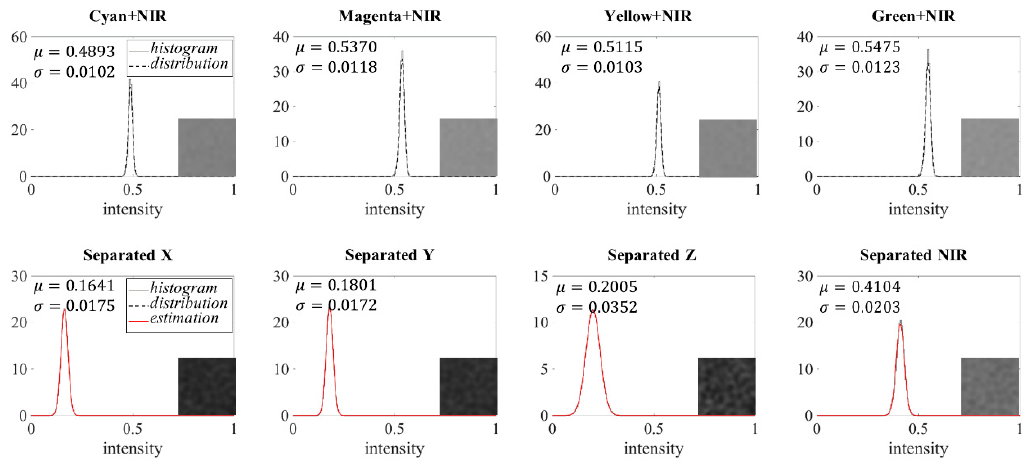
Figure 3. The noise distribution of the input and the separated images (in images of grey surface object taken under fluorescent and 850 nm light).